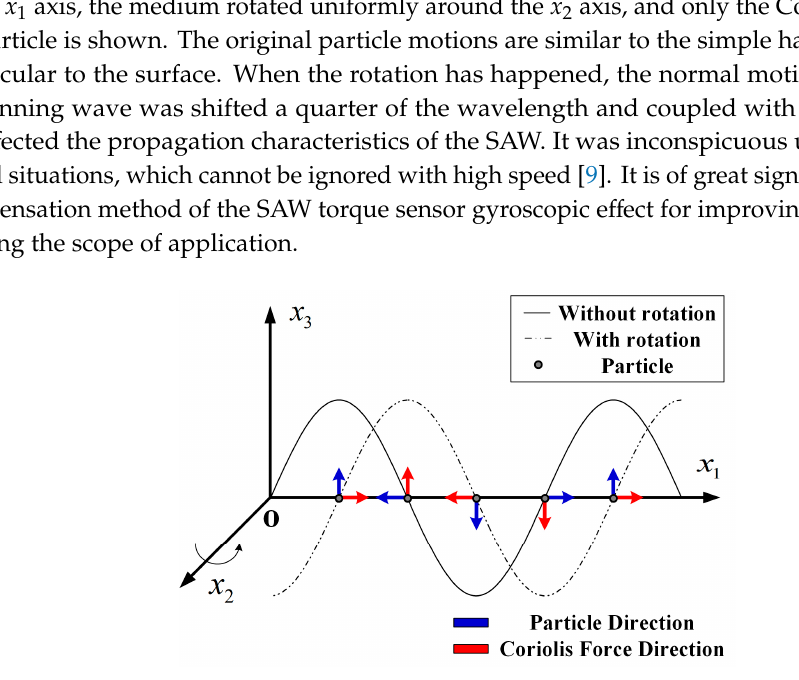
Figure 1. The effect of gyroscopic on the surface acoustic wave (SAW)